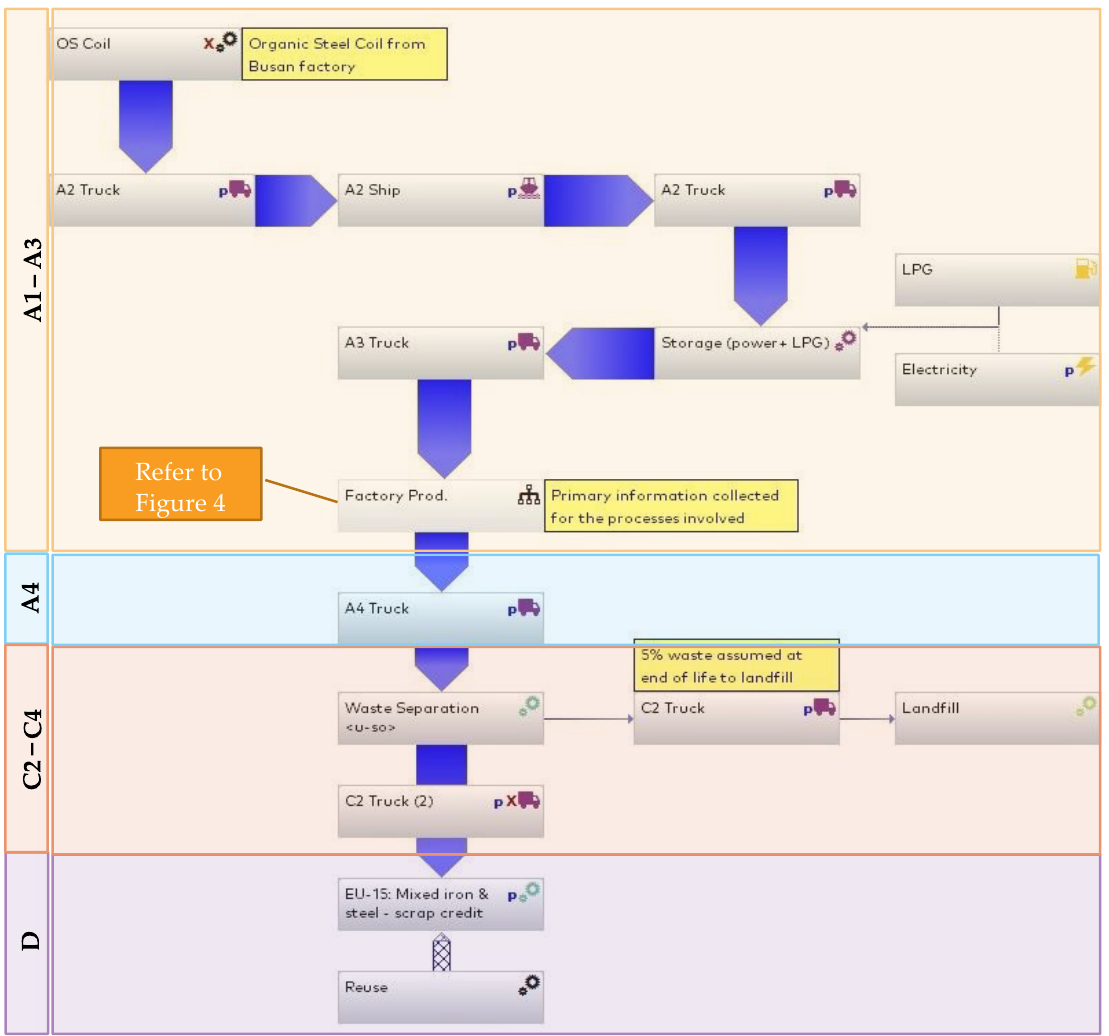
Figure 3. Overview of the case steel roofing aggregate processes in GaBi Ts software.